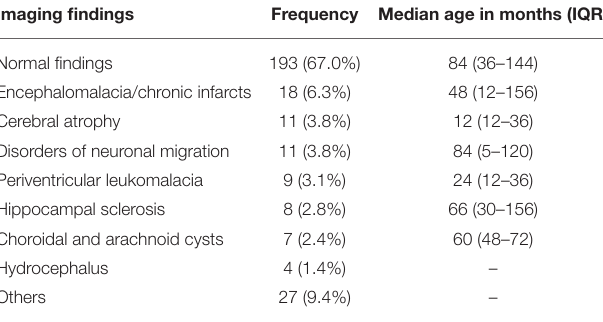
TABLE 1 | Summary of imaging